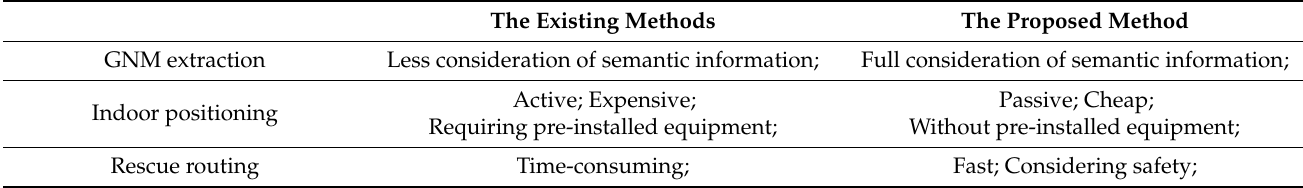
Table 1. Comparison between the existing methods and the proposed method. The Existing Methods The Proposed Method GNM